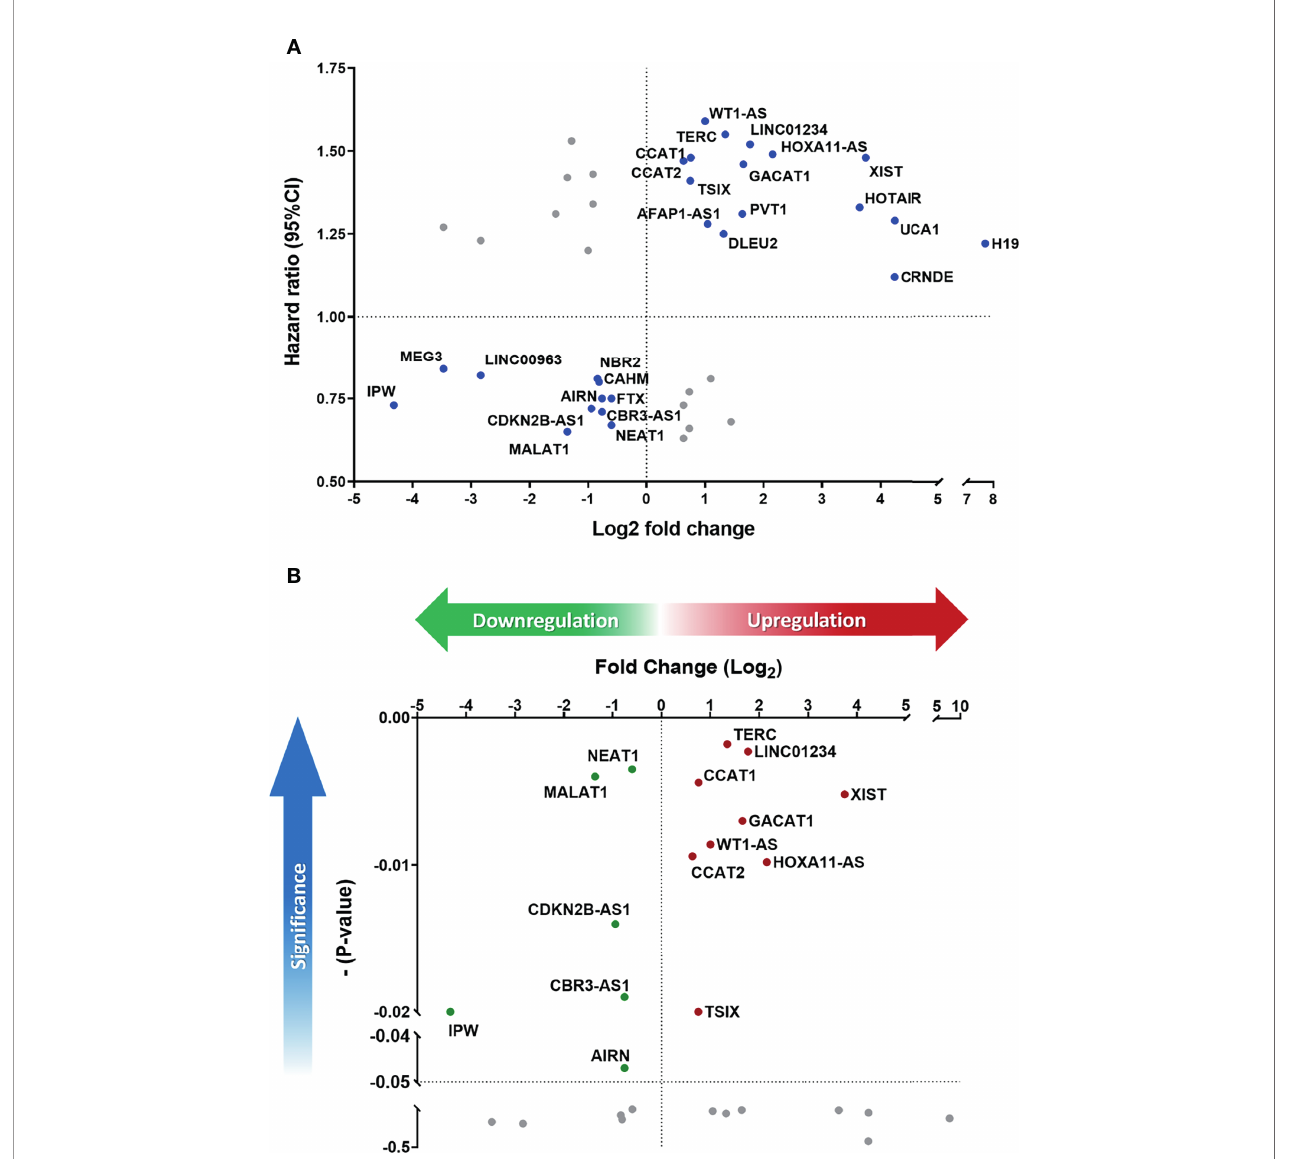
FIGURE 3 | De fi ning the lncRNA panel based on correlation between gene expression and prognostic information. (A) HR versus log 2 -fold change (FC) dot-plot of 41 signi fi cantly dysregulated lncRNAs from the PCR array. In total, 27 lncRNAs were correlated with high risk score. (B) Overall survival p-value versus log 2 -FC of 27 positively correlated lncRNAs. A total of 15 lncRNAs were signi fi cantly correlated with cancer prognosis (p-value ≤